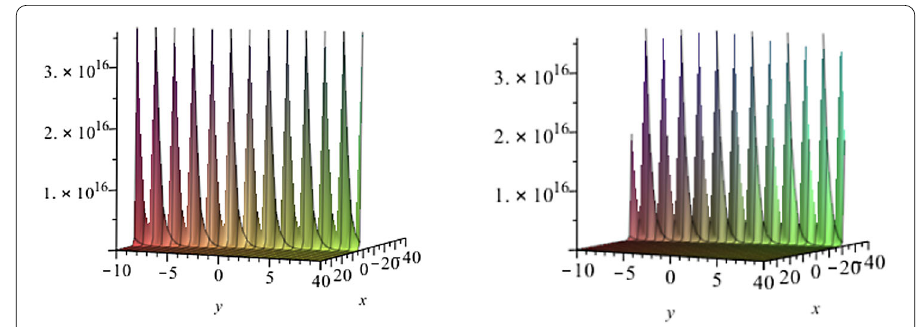
Figure 1 Solitary wave solution of Eq. (4.8) with β = 0.5 and β = 0.9, respectively, when λ = –1